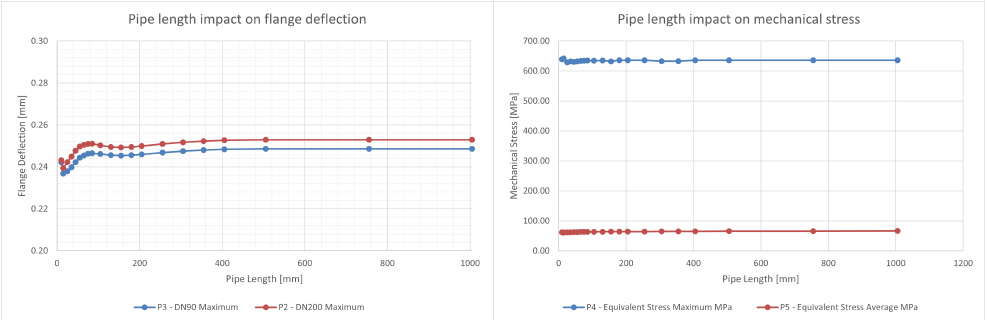
Figure 9. Effects of pipe length to flange deflection and mechanical stress.